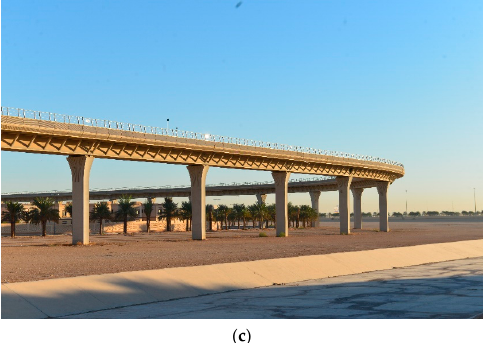
Figure 1. Images show PNU metro system. ( a ) Metro map. ( b ) Metro vehicle. ( c ) Metro